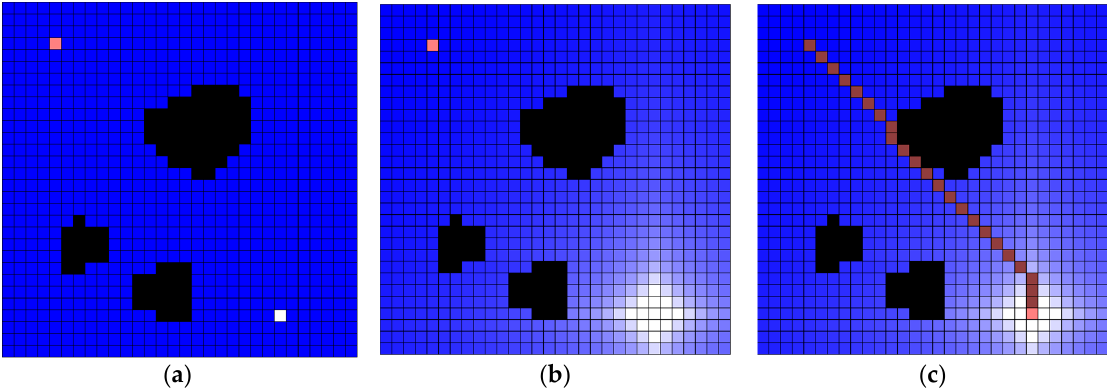
Figure 11. Water sink model simulator example. Example is 20 (pixels) cell size, 30 × 30 cells and the following is a series of map creation, water drainage, and robot path. The drainage water is 1000 per turn: ( a ) there are three obstacles, the robot is located at the upper-left corner, and the plughole is located at the lower-right corner; ( b ) water drainage progressed up to 50 turns; and, ( c ) final result of robot path.